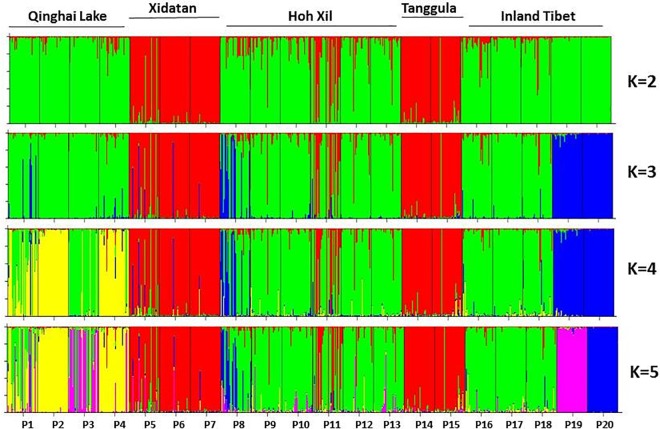
Genetic divergence in the S. purpurea populations illustrated by STRUCTURE with K = 2 to 5.Each line represent the membership coefficients (Q) of individual plants. Population codes are indicated below and the sampled geographical regions.are shown above.